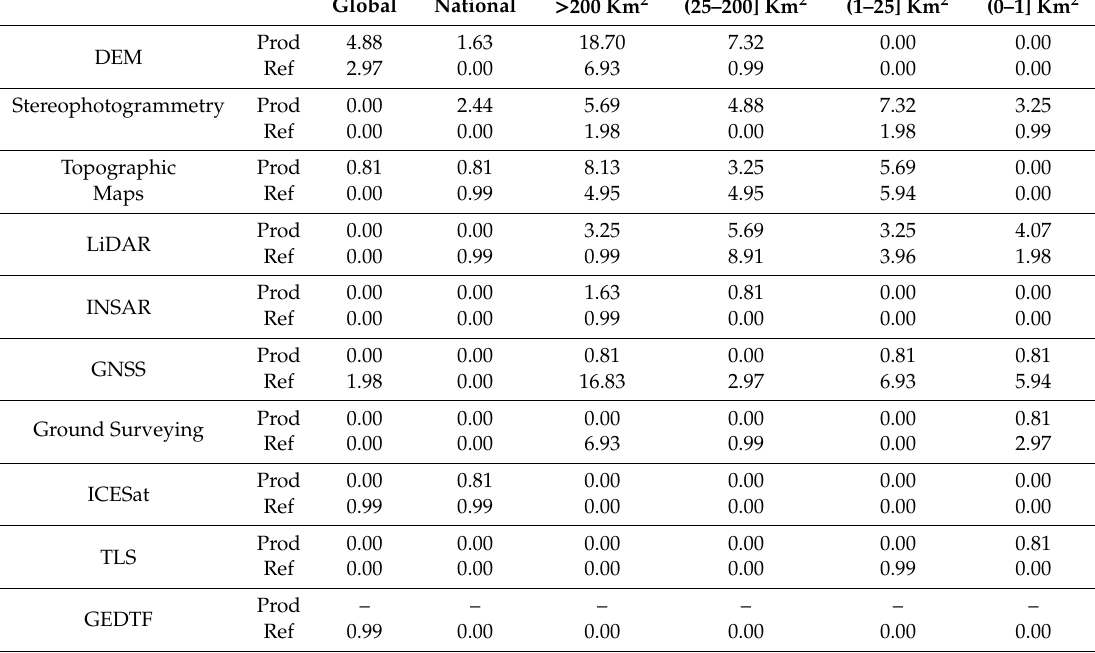
Table 3. Cross tabulation between extension (km 2 ) and data sources for products and reference data (% of